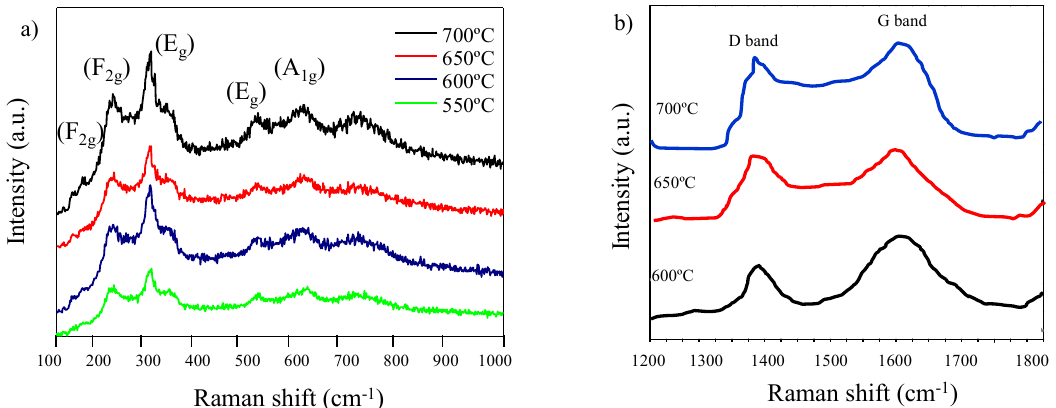
Figure7. Micro-RamanspectraofmesoporousLi 4 Ti 5 O 12 thinfilmsheat-treatedatdi ff erenttemperatures Figure 7. Micro-Raman spectra of mesoporous Li 4 Ti 5 O 12 thin films heat-treated at different ( a ) 100–1000 cm − 1 and ( b ) 1200–1800 cm − 1 . temperatures ( a ) 100–1000 cm −1 and ( b ) 1200–1800 cm −1 . Table 1. Main assignments of Raman bands of mesoporous Li 4 Ti 5 O 12